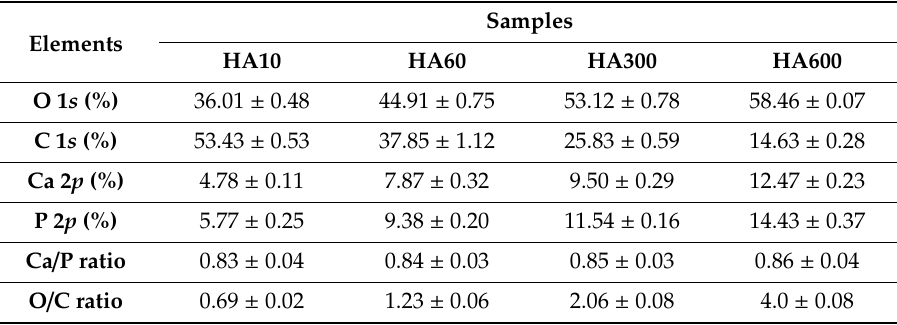
Table 5. Percentage of di ff erent of di ff erent elements and their ratios.